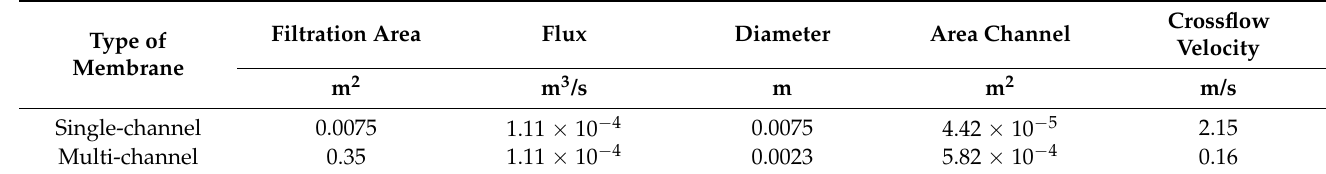
Table 2. Filtration and cross-flow conditions of the rejection tests.